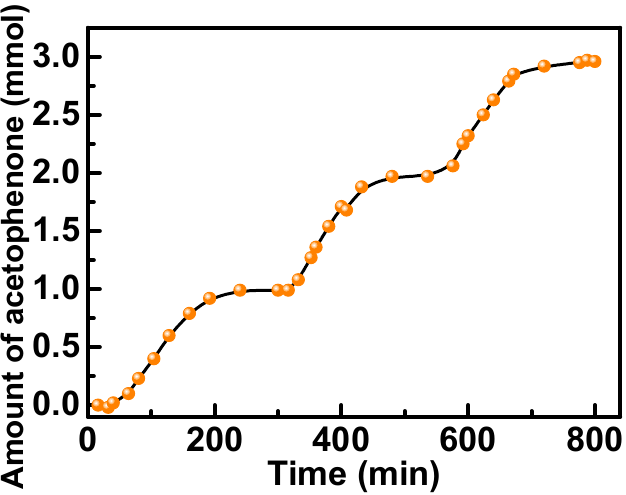
Figure 2. The time profile for the successive oxidation of 1-phenylethanol with Au / meso-Fe 2 O 3 . Reaction conditions: 1-phenylethanol (1 mmol), catalyst (100 mg), diphenyl ether (10 mL), 80 °C, p = 1 atm. air (30 mL · min − 1 ).